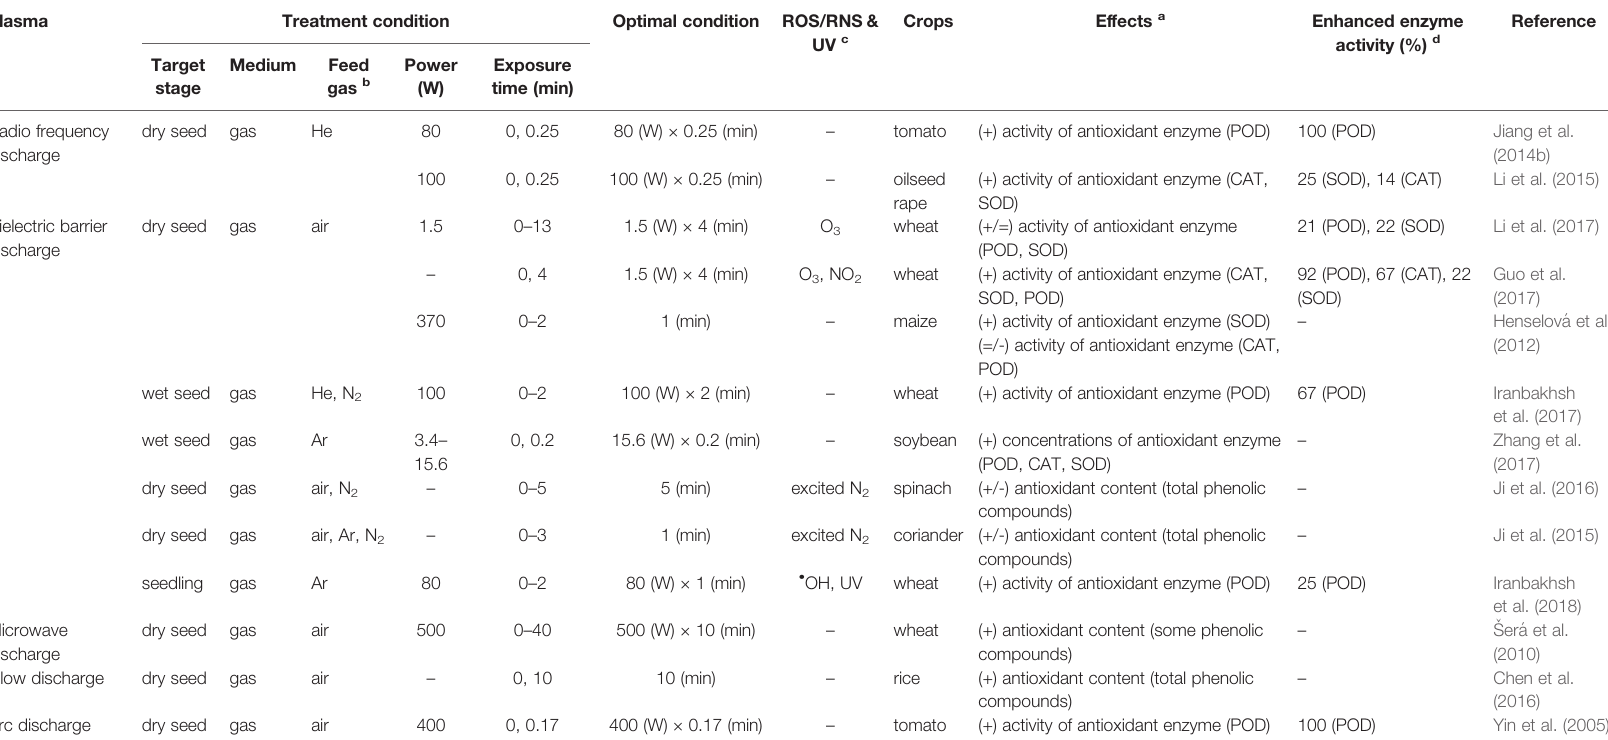
TABLE 3 | The enhancement effect of the plasma treatments on cellular antioxidant systems in crops, including cereals, legumes, and